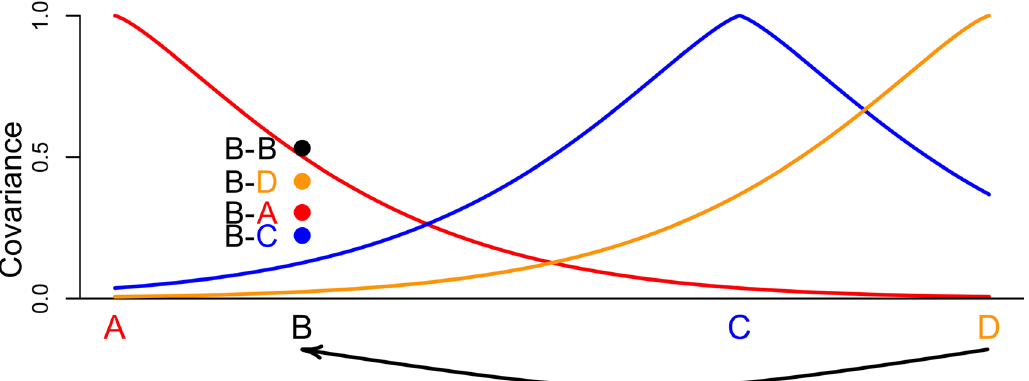
Fig 11. Illustrated example of spatial covariance and the effects of admixture. Lines show the covariances populations A , C , and D would have with population B as a function of B ’ s location with no admixture, under the parametric form of Eq (2). The colored dots above ‘ B ’ show the covariances observed with B at that location given that B has 40% admixture from D . There is no spatial configuration that induces unadmixed covariances remotely similar to those